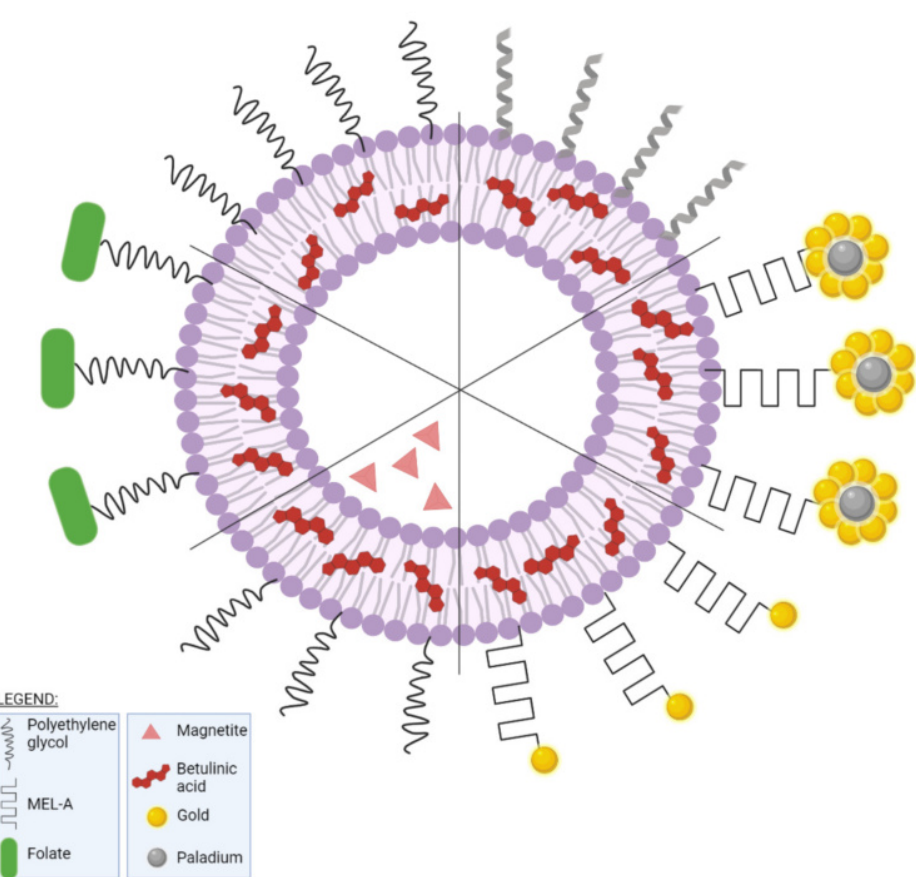
Figure 17. Schematic representation of different reported BA liposomal formulations. Created with BioRender.com (accessed on 10 January